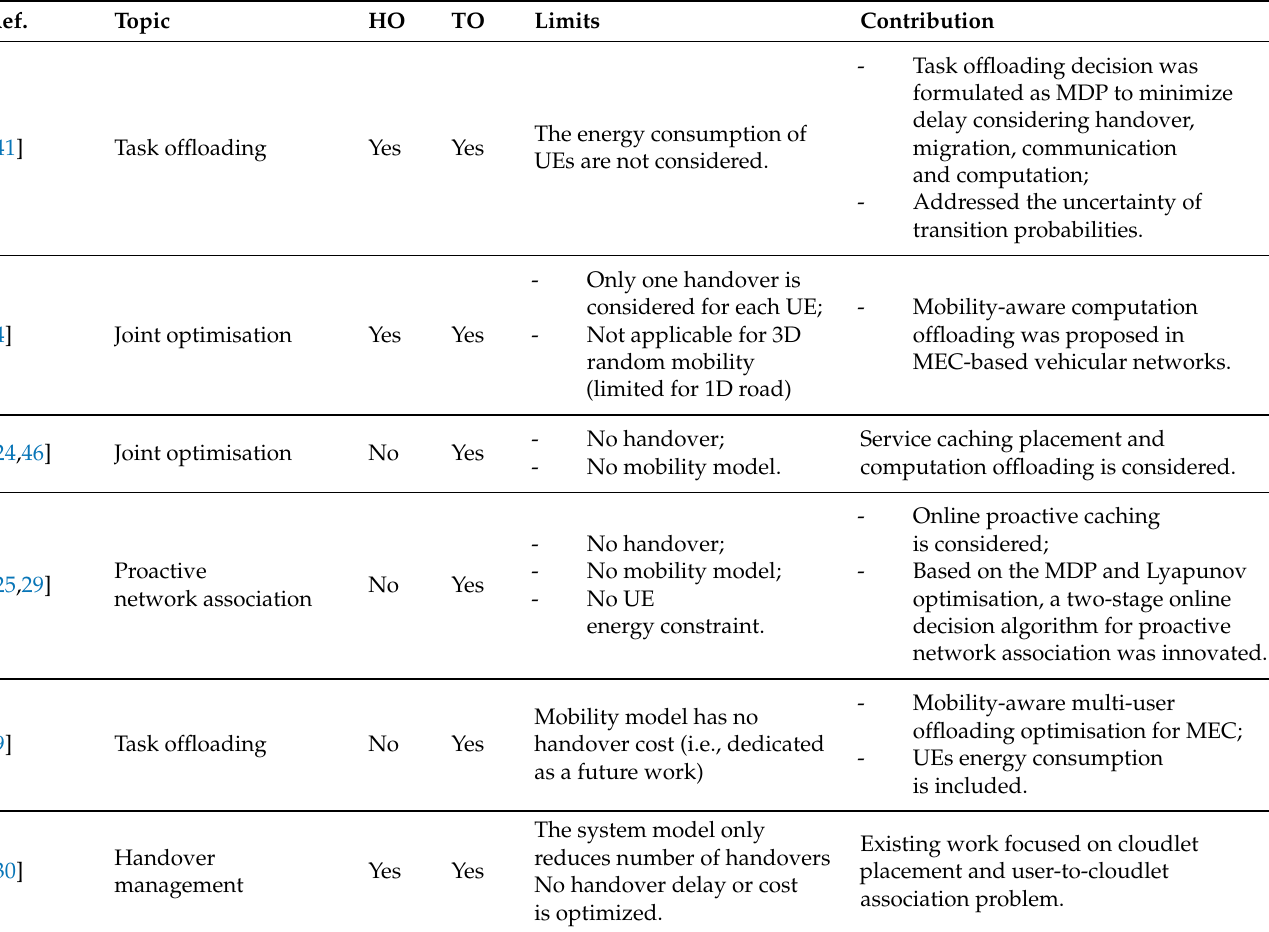
Table 2. Summary of related studies on handover decision optimisation in